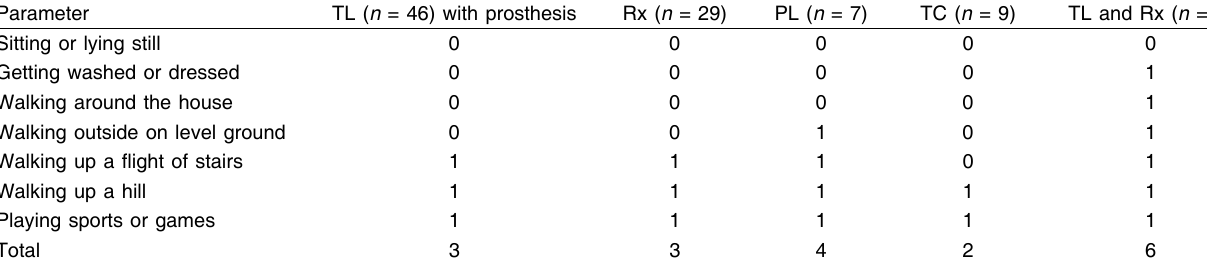
Table 8 Results of modi (cid:383) ed SGRQ